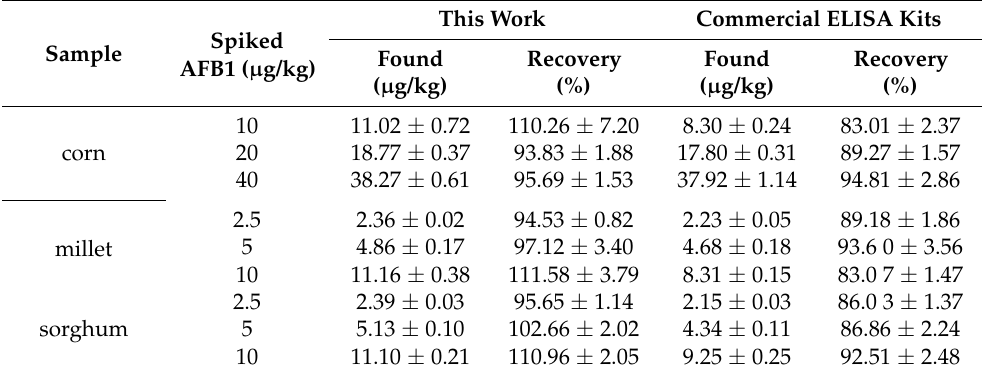
Table 2. Applications of the developed sensor for AFB1 in different cereal samples and verification with a commercial ELISA kit. ( n =